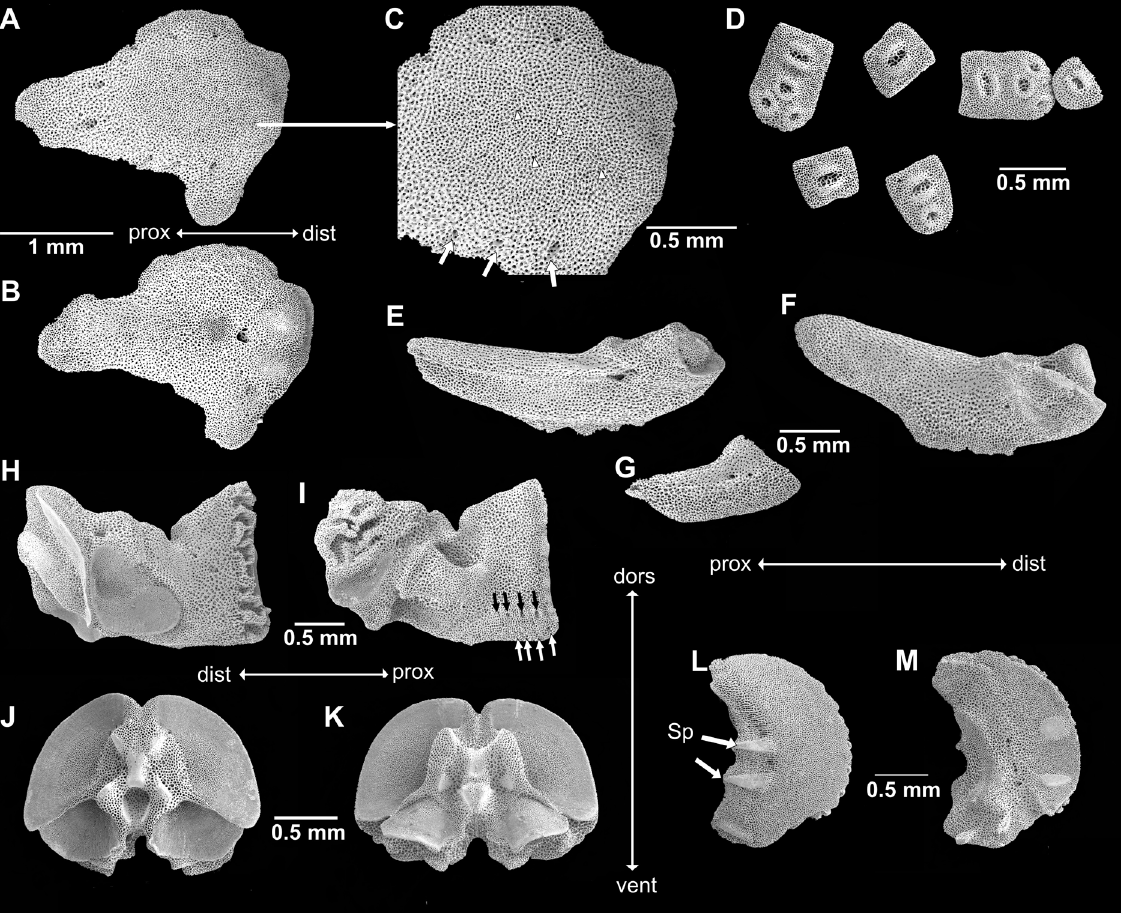
Fig. 6. SEM images of skeletal elements of Ophioderma guineense Greef, 1882, Thiouriba, Senegal, from specimen of 11.7 mm disc diameter (SMHN-178429). A . Radial shield external. B . Radial shield internal. C . Scale-free area magnified from Fig. 6A, white arrowheads point to granule sockets and pores, white arrows point to larger peripheral pores. D . Dental plate fragments. E – F . Adradial genital plate, two opposite lateral aspects. G . Abradial genital plate. H . Oral plate, abradial face I . Oral plate adradial face, black arrows point to oral papillae sockets and pores, white arrows point to granule socket pores. J . Arm vertebra proximal face. K . Arm vertebra distal face. L . Lateral arm plate, external face. M . Lateral arm plate, internal face. Abbreviations: dist = distal; dors = dorsal; prox = proximal; Sp = spurs; vent =